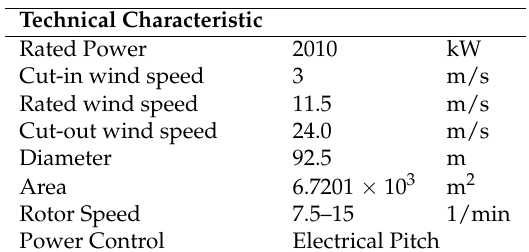
Table 1. Manufacturer Data of the Wind Generator model employed in the analyzed wind farm.